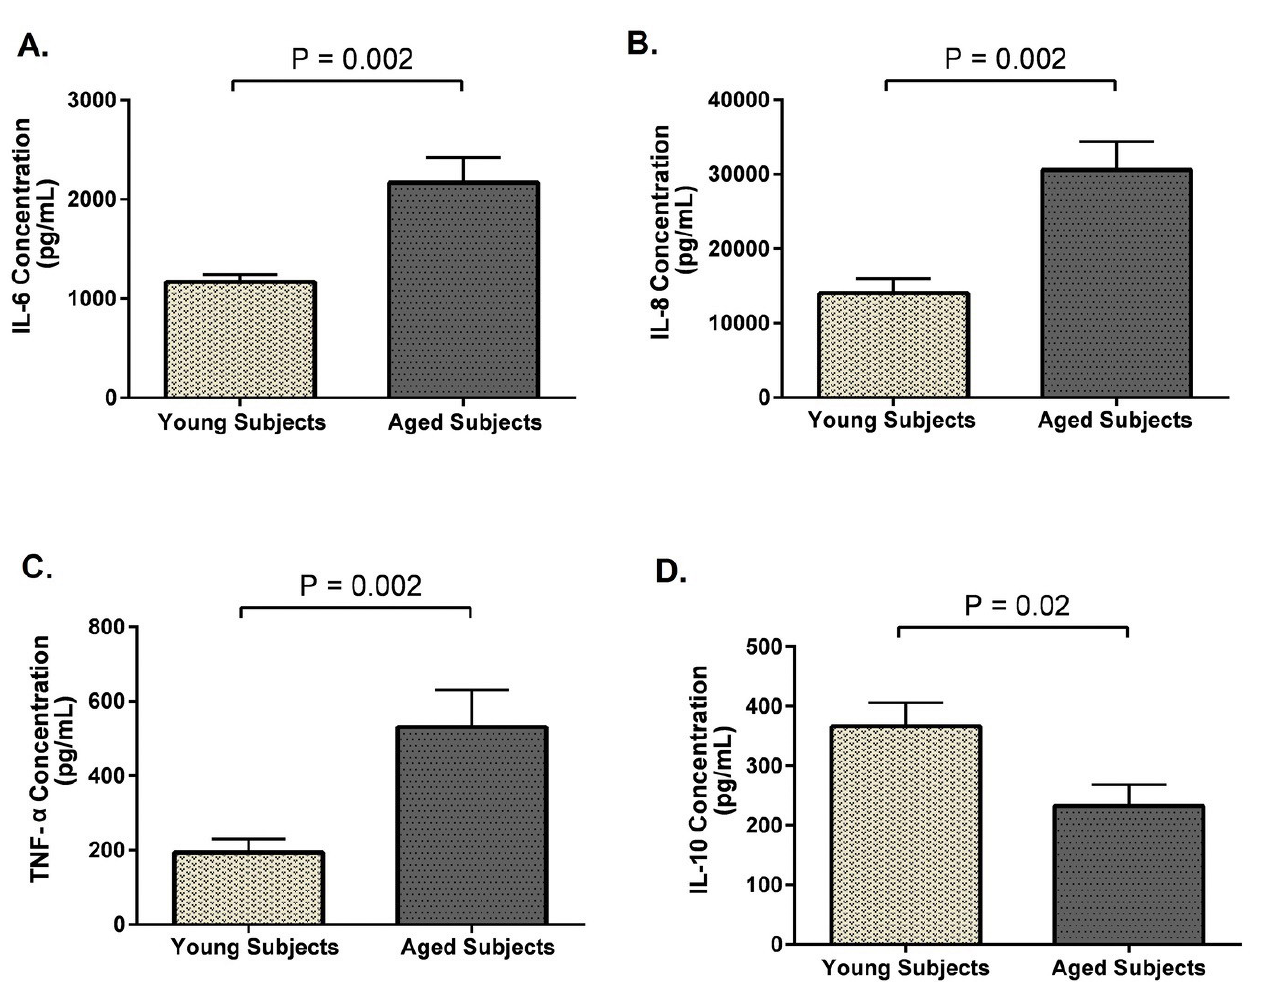
FIGURE 3 - Cytokine production from PBMCs treated by donkey’s milk in young subjects and aged subjects (by ELISA). (A) IL-6 levels, (B) IL-8 levels, (C) TNF- α levels, and (D) IL-10 levels from subjects. (A-D) The results are represented as Mean ± SEM. Statistical comparisons made by Mann Whitney test, differences were considered statistically significant for